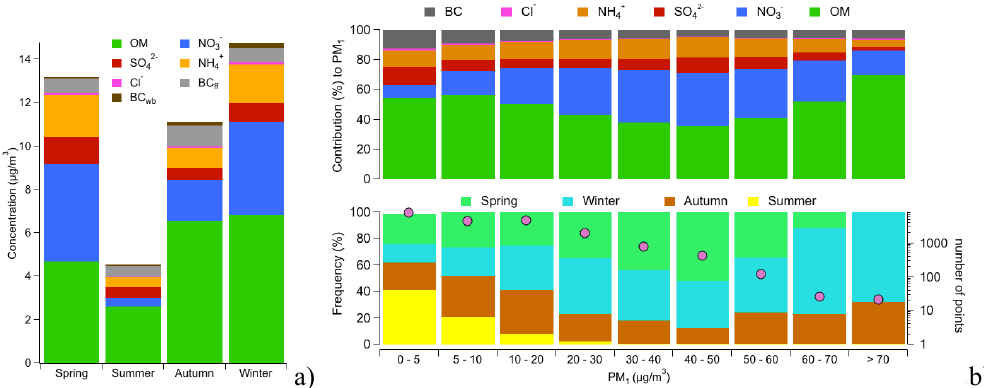
Figure 6. (a) PM 1 chemical composition for different mass classes (top), with the seasonal occurrence frequency and number of points in each bin (bottom) and (b) seasonal PM 1 chemical